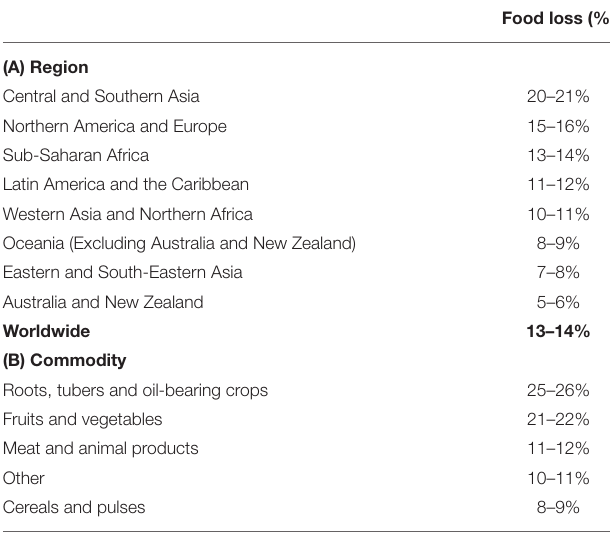
Table based on information provided by the U.S. Environmental Protection Agency (EPA)